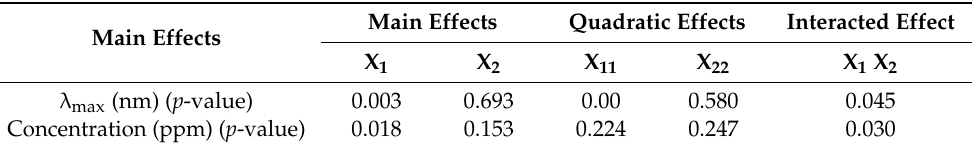
Table 3. p -Values of the regression coefficients in the obtained